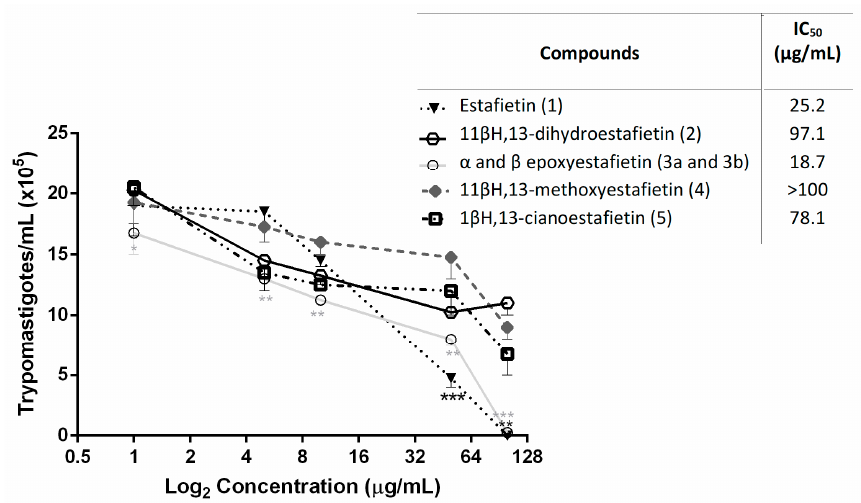
Figure 2. Trypanocidal activity of estafietin ( 1 ) and estafietin derivatives ( 2 – 5 ) against T. cruzi bloodstream trypomastigotes . Bloodstream trypomastigotes were assayed in duplicate in the presence of 0 to 100 µg/mL of estafietin ( 1 ), 11 β H,13-dihydroestafietin ( 2 ), α - ( 3a) and β - epoxyestafietin ( 3b ) (1:4 mixture), 11 β H,13-methoxyestafietin ( 4 ) and 11 β H,13-cianoestafietin ( 5 ). Cultures were done in 96-well plates with 1.5 × 10 6 parasites/mL over 24 h. The living parasites were then counted in a Neubauer chamber. Symbols represent mean ± SEM. Each treatment was compared to controls: parasites incubated with culture medium only. * p < 0.05, ** p < 0.01 and *** p < 0.005.